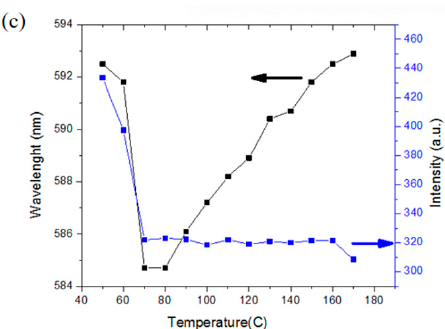
Figure 4. ( a ) The current voltage (IV) curves of the white QD LEDs at room temperature; ( b ) The Figure 4. temperature dependent electroluminescence (EL) spectra of the white QD LEDs at 50 °C–170 °C.; ( c ) The temperature dependent EL peak intensity and wavelength at 350 mA.